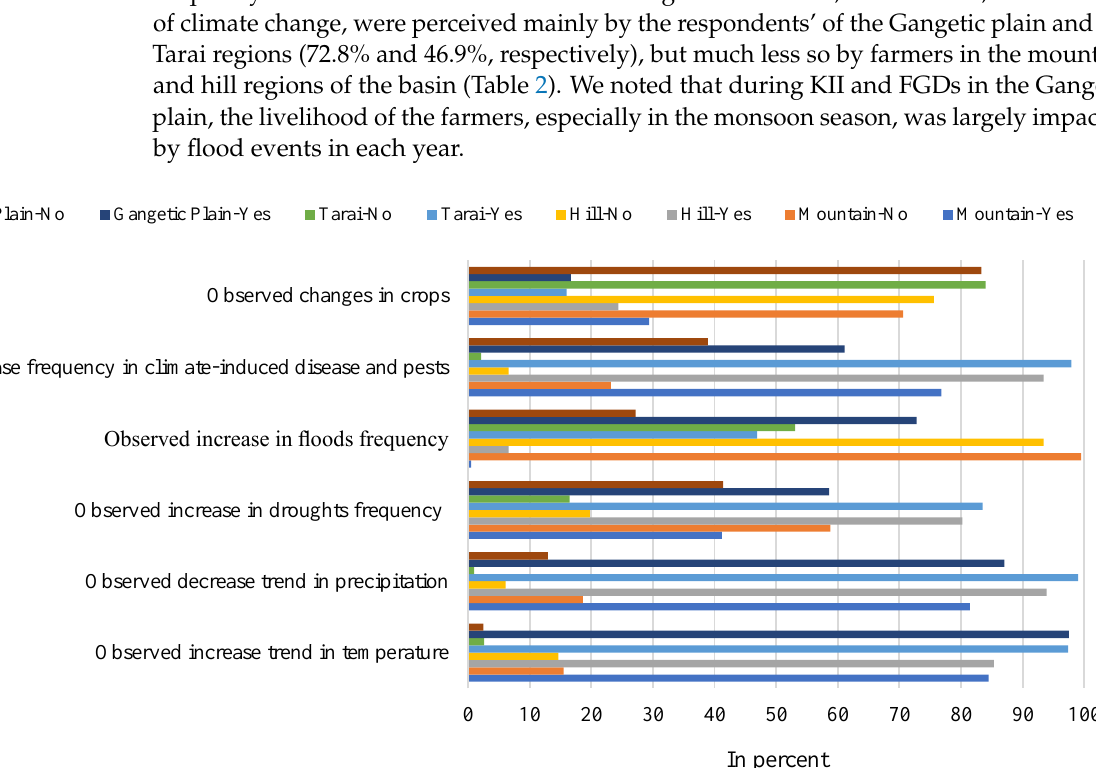
Table 3. The observed impacts of climate change by the local respondents’ in the various sectors for the trans -boundary KRB. Observed Major Impacted Sectors Basin Level Responses (%)